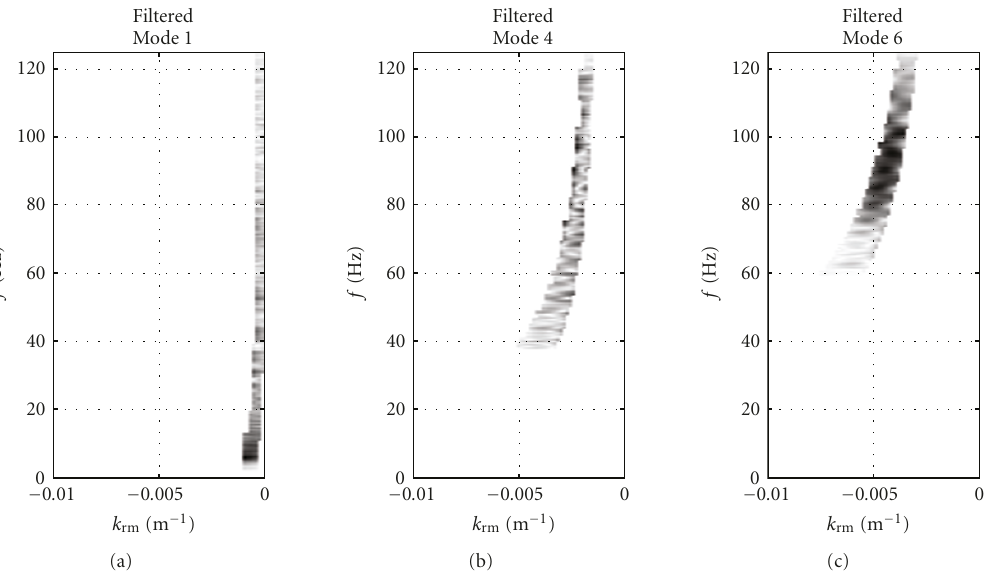
Figure 11: Modes nos. 1, 4, and 6 extracted from F - K representation given in Figure 7(a) by mask filtering.